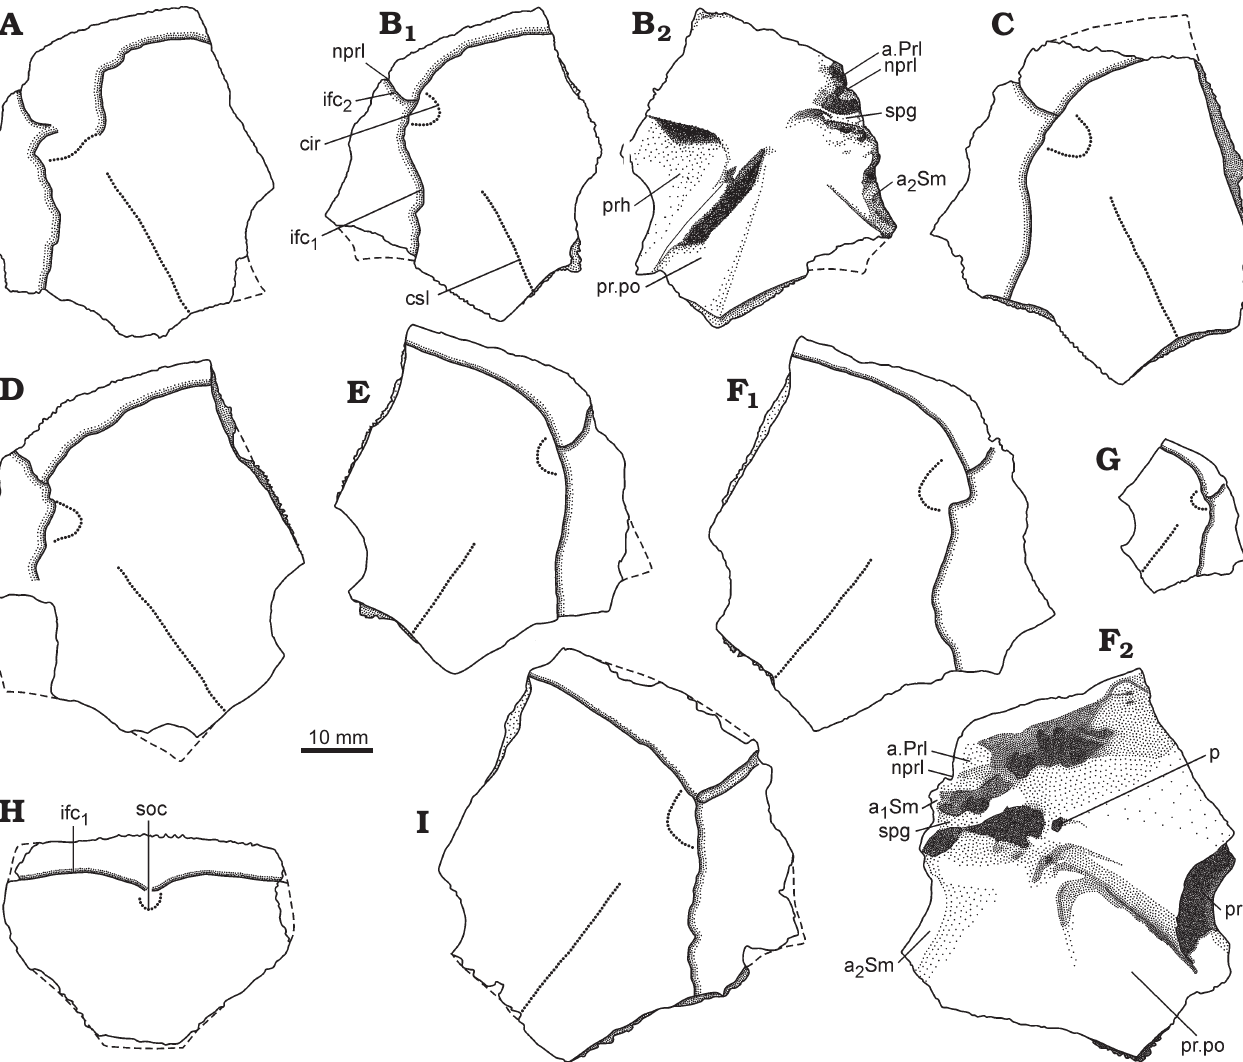
Fig. 5. Antiarchan fish Bothriolepis leptocheira jeremejevi (Rohon, 1900), lateral (A–G, I) and premedian (H) plates of the head shield. A . IG KSC 155/15 in dorsal view. B . IG KSC 155/67 in dorsal (B 1 ) and visceral (B 2 ) views. C . IG KSC 155/129 in dorsal view. D . IG KSC 155/74 in dorsal view. E . IG KSC 155/65 in dorsal view. F . IG KSC 155/66 in dorsal (F 1 ) and visceral (F 2 ) views. G . IG KSC 155/69 in dorsal view. H . IG KSC 155/114 in dorsal view. I . IG KSC 155/64 in dorsal view. Abbreviations: a 1 Sm and a 2 Sm, anterior and posterior attachment areas on lateral plate for submarginal plate; a.Prl, attachment area on lateral plate for prelateral plate; cir, semicircular pit-line groove; csl, central sensory line groove; ifc 1 , principal section of infraorbital sensory line; ifc 2 , branch of infraorbital sensory line diverging on La; nprl, prelateral notch of head shield; p, lateral pit of head shield; prh, preorbital recess of head shield; pr.po, antero-lateral corner of otico-occipital depression; soc, anterior section of the supraorbital sensory line; spg, spiracular groove of head